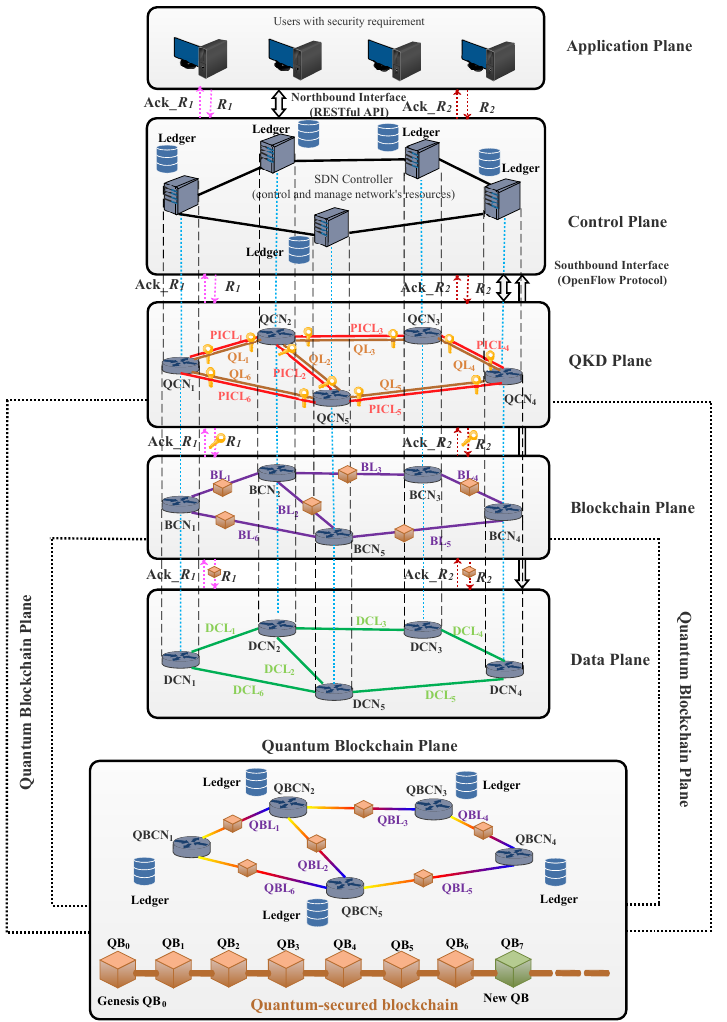
Figure 10. Distributed quantum-secured blockchain-based optical network architecture